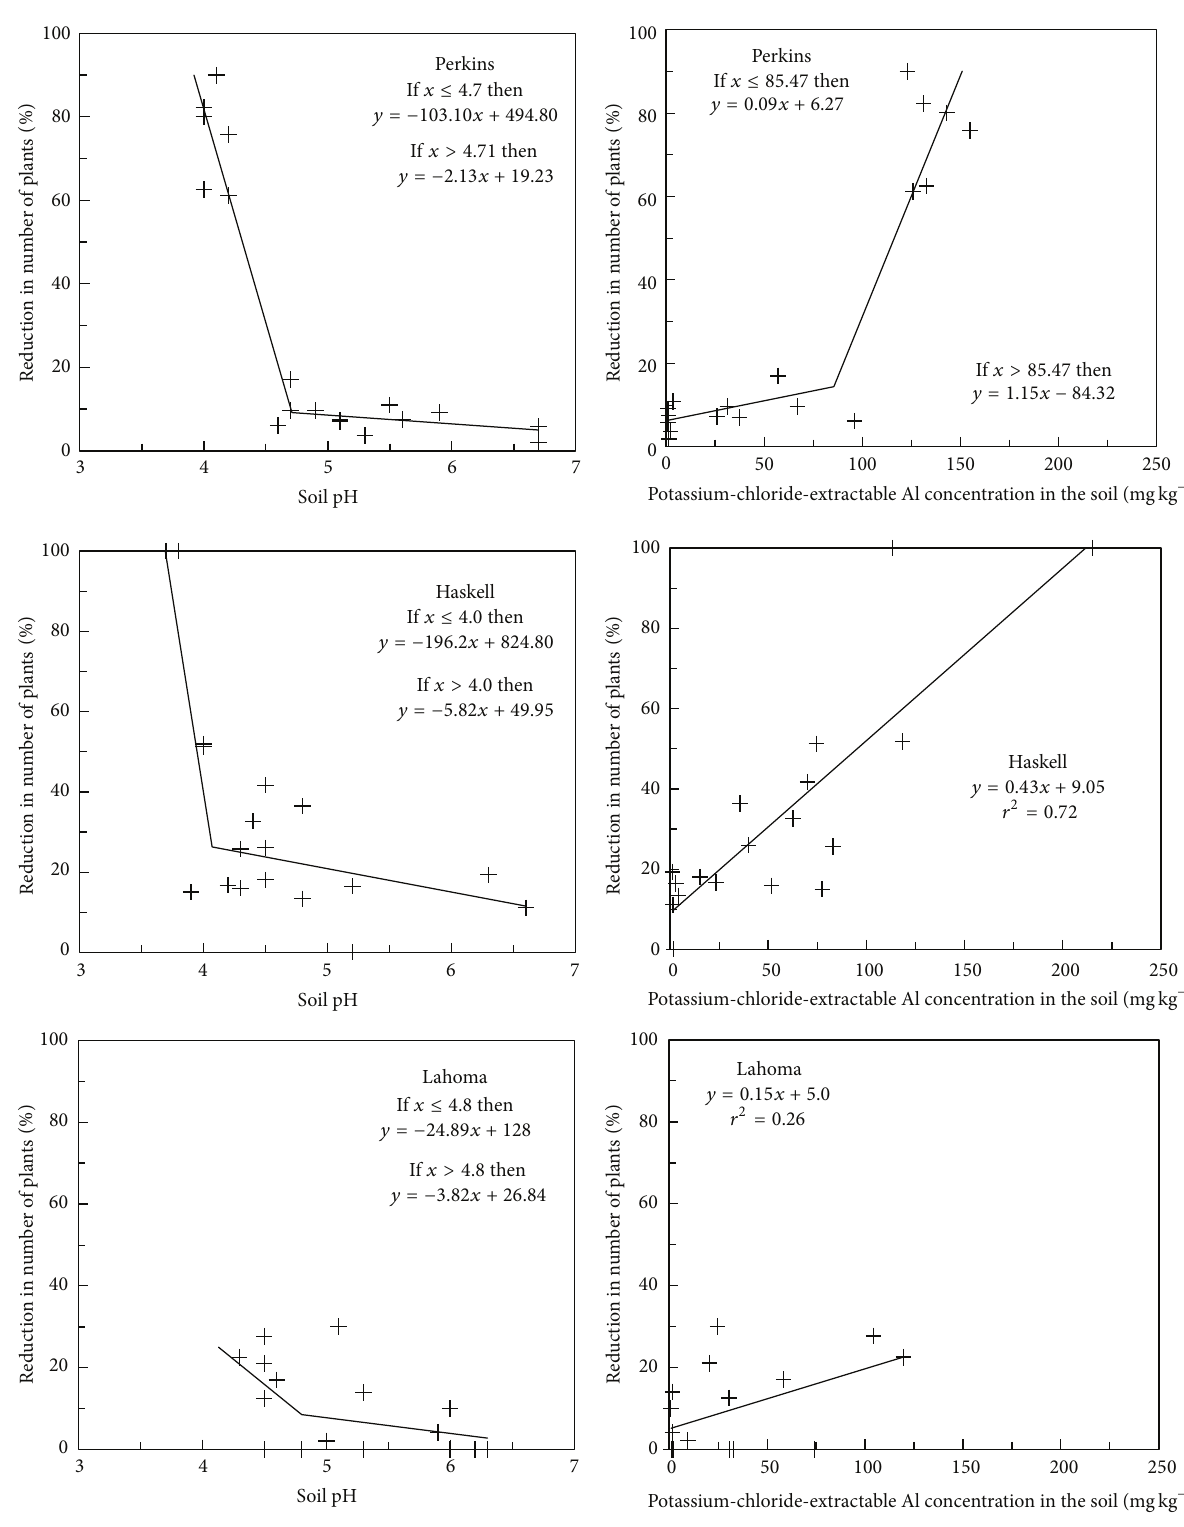
Figure 4: Percent reduction in number of sunflower plants from emergence to harvest as a function of soil pH and potassium-chloride- extractable aluminum concentration (mgkg −1 ) in the soil at Perkins, Haskell, and Lahoma, Oklahoma, in